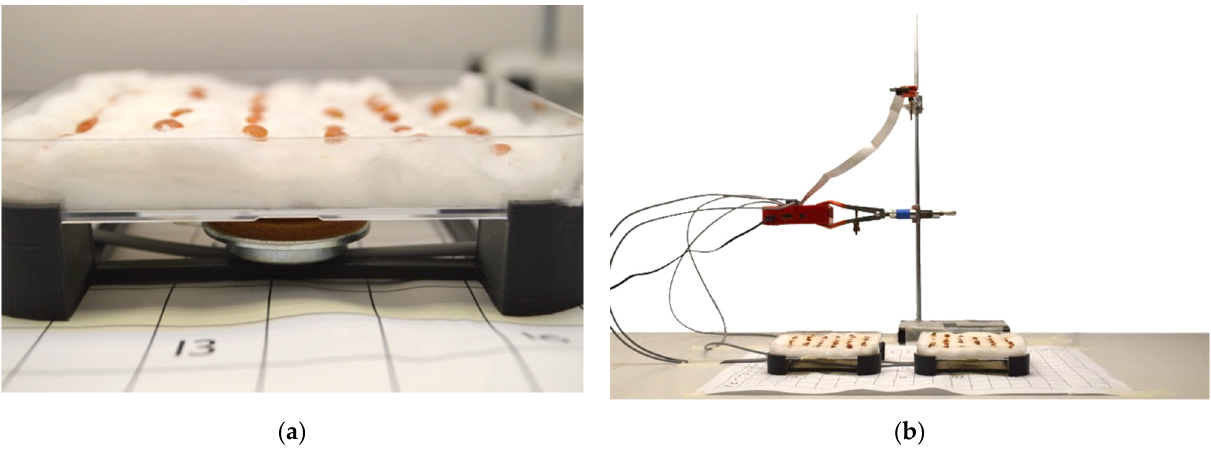
Figure 3. Arrangement of the plates on a plastic support in order to correctly expose the samples to the stimuli ( a ) and an overview of the experimental setup with the locations of all used devices ( b ).